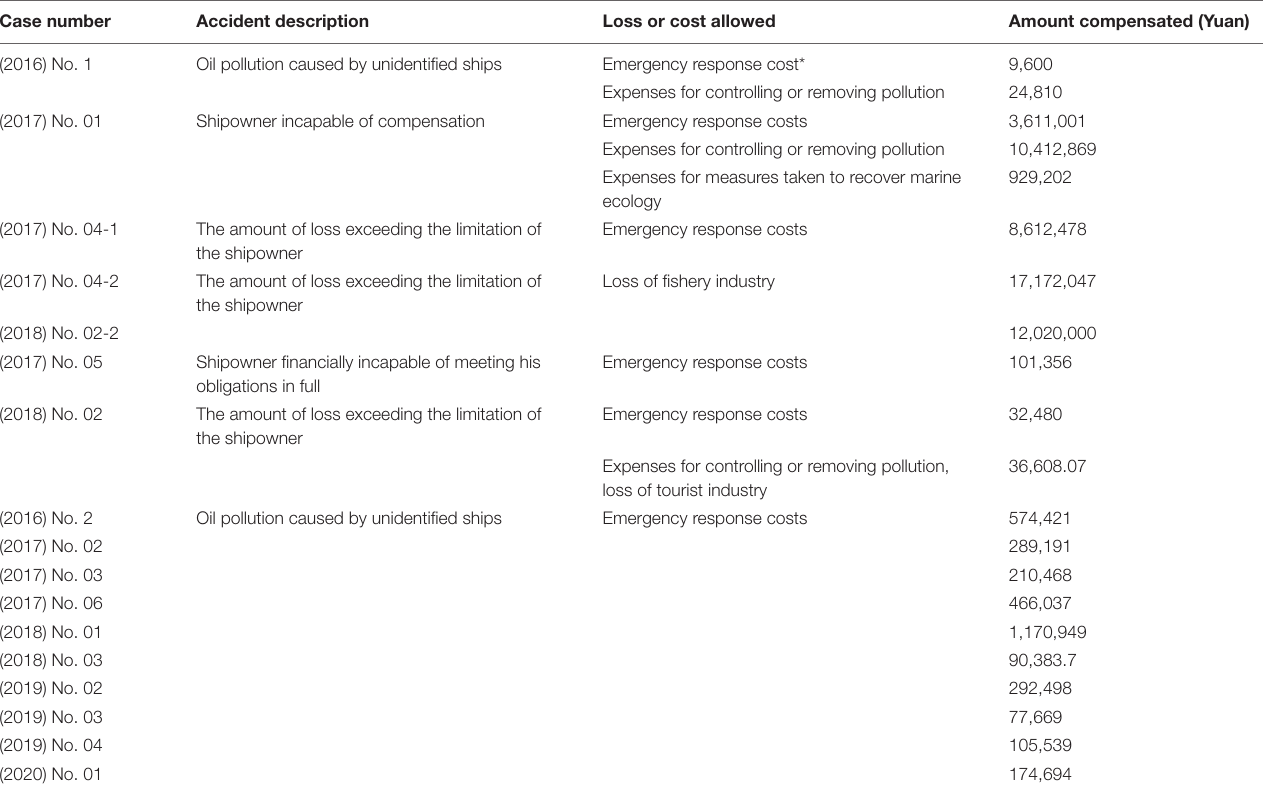
TABLE 1 | The claim settlement decisions of CSOPC